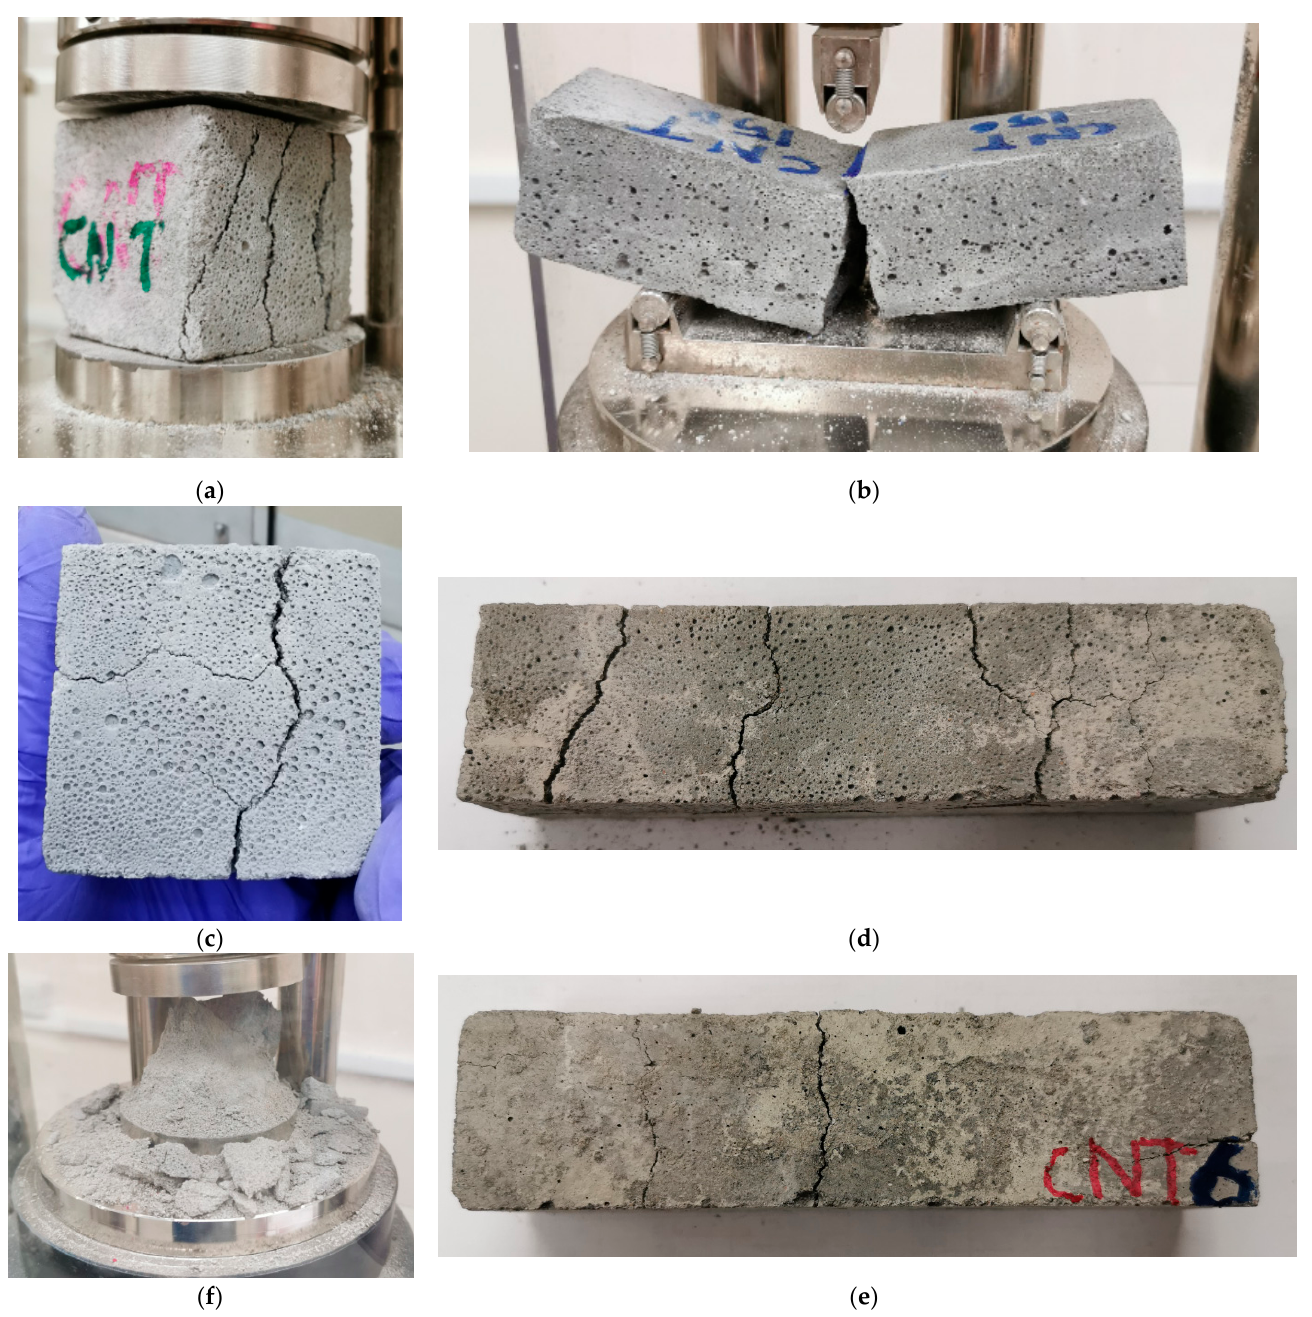
Figure 10. Typical failure mode of specimens heated up to 450 ◦ C: ( a ) compression; ( b ) flexural, thermal cracks caused by heating at 600 ◦ C; ( c ) compression specimens; ( d ) control flexural specimens; ( e ) CNT-reinforced flexural specimens; and ( f ) compression specimens heated at 600 ◦ C after compression